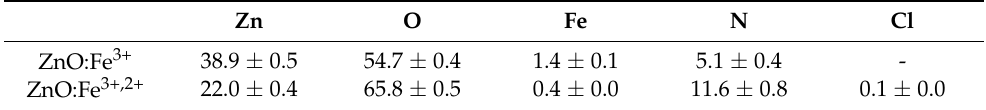
Table 1. Energy-dispersive X-ray spectroscopy (EDX) measured elemental composition of ZnO:Fe 3+ and ZnO:Fe 3+,2+ samples. Concentrations given in atomic